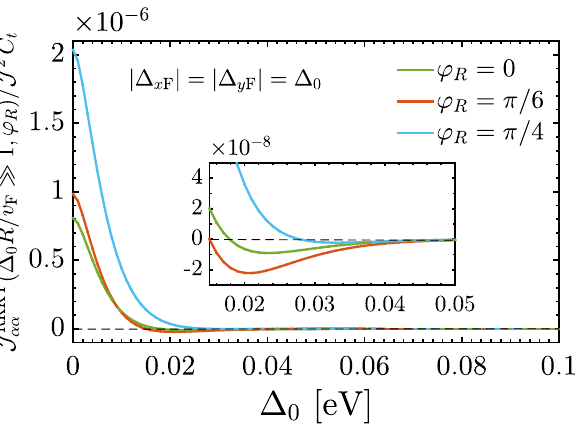
2 C 1, ϕ R )/ J t as a function of ≫ 200 Å for different directions ϕ R . It is evident that the RKKY =